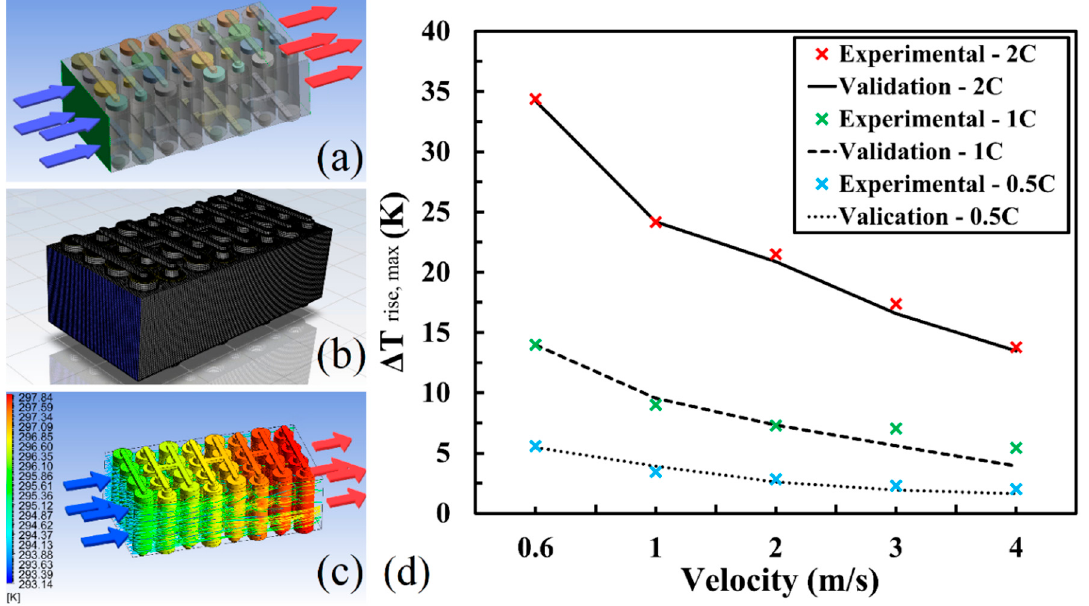
Figure 4. Model validation: ( a ) validation model; ( b ) CFD mesh; ( c ) battery surface temperature contour and air velocity streamlines at 4 m/s 20 °C inlet air during 0.5C discharging; ( d ) the comparison between the experimental data in Ref. [38] and the validation results in this study at 3 different discharging rates.